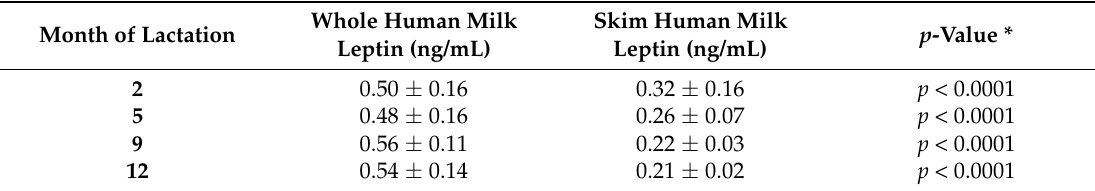
Table 3. Leptin concentrations for whole and skim human milk at each month of lactation. Values are mean ± SD.